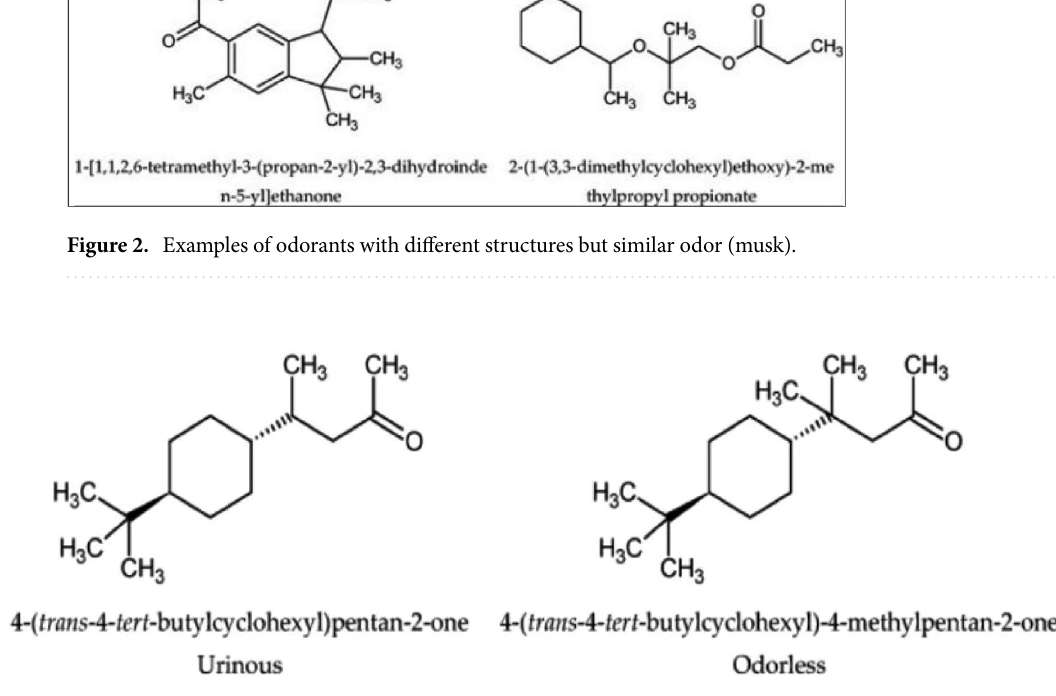
Figure 3. Example of the changing odorant character of a compound with slight structural